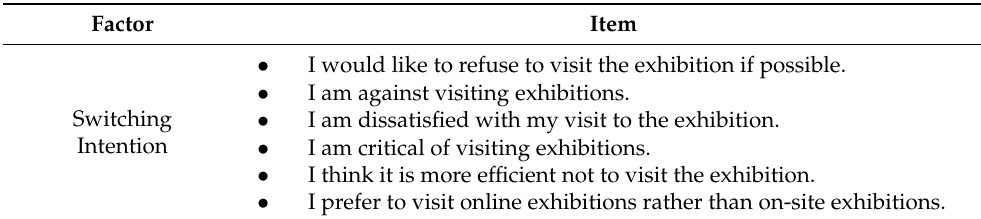
Table 3. Switching intention of exhibition